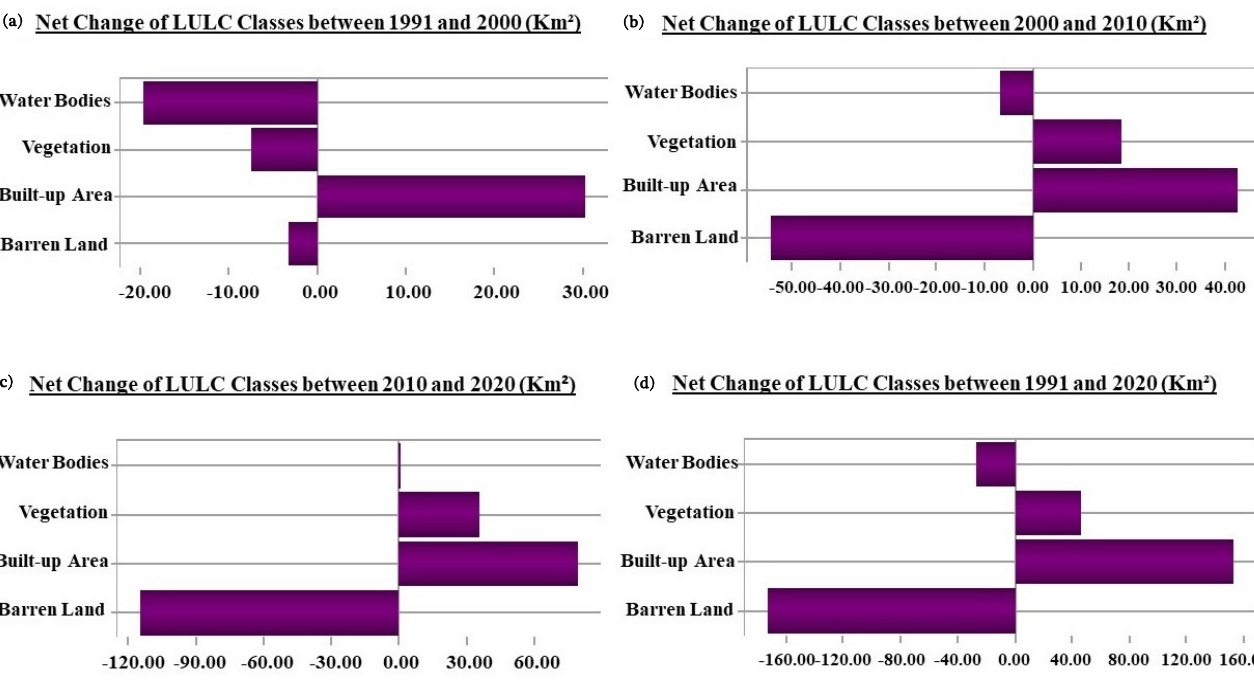
Figure 5. Detection of LULC change dynamics between, ( a ) 1991 and 2000, ( b ) 2000 and 2010, ( c ) 2010 and 2020, and ( d ) 1991 and